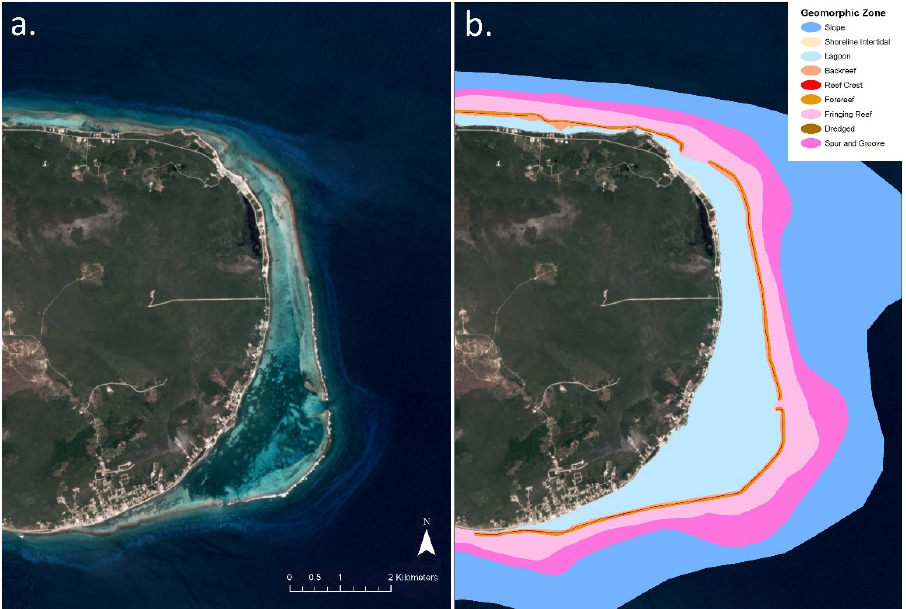
Figure 5. Example of manually digitized geomorphic zones based on image interpretation of PS imagery in East end, Grand Cayman: ( a ) PlanetScope Dove imagery surface reflectance; ( b ) derived geomorphic zones showing the shallow lagoon separated from the deeper shelf by the reef crest formation with the back (inner) and fore (outer) reefs.